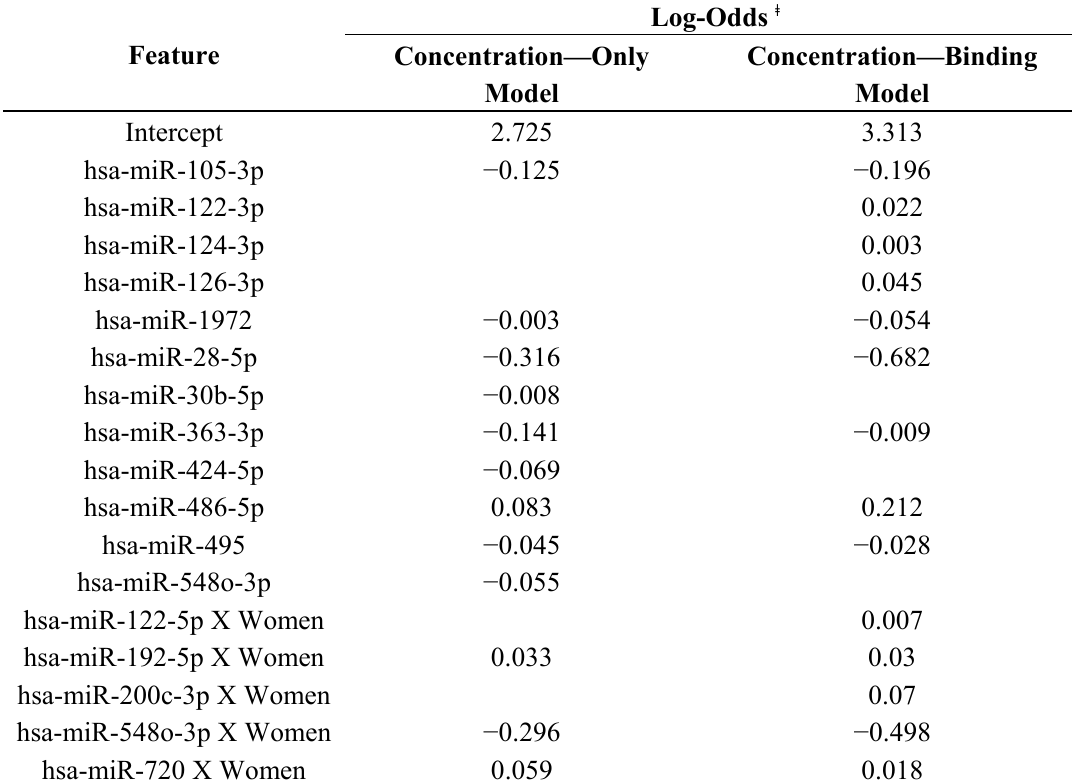
Table 2. Predictive models for the future development of